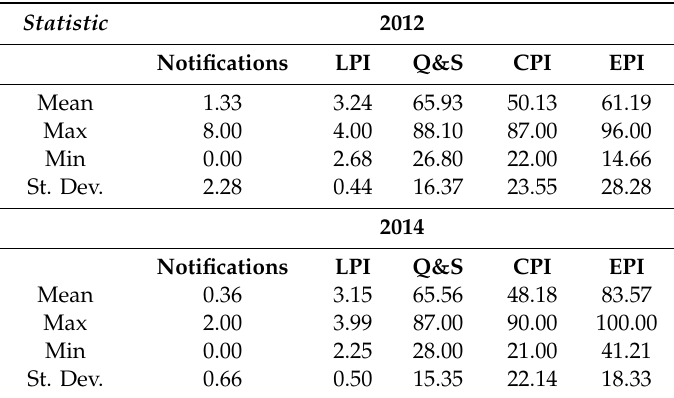
Table 5. Main statistics for criteria in sample of EU cereal